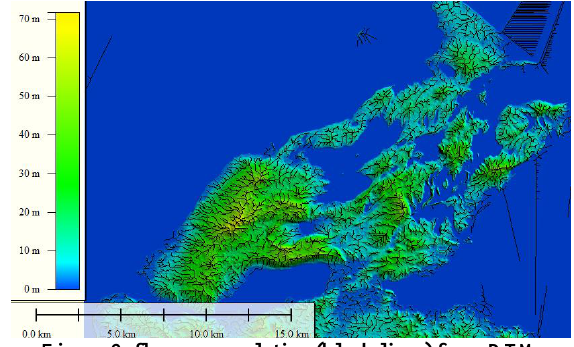
Figure 9. flow accumulation (black lines) from DTM DTM can also be used to make slopes. The slope in the Rote seen in Figure 10.